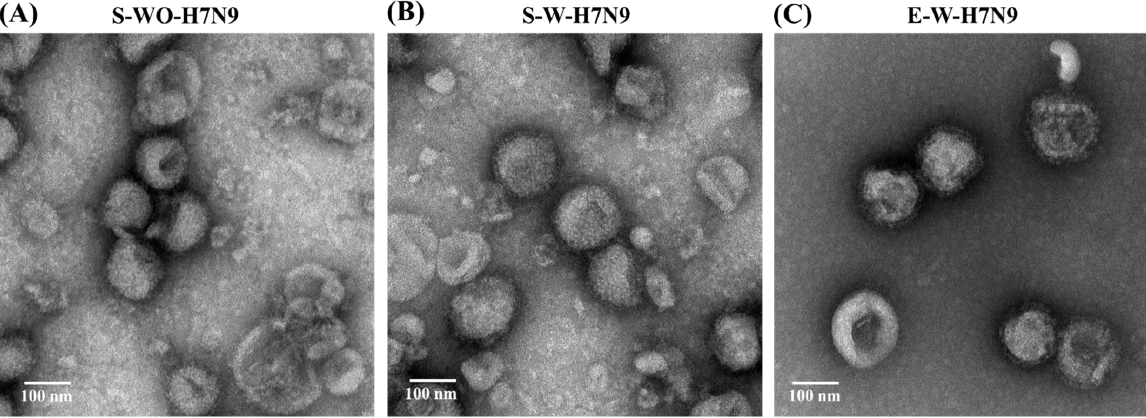
Figure 2. Morphology of three influenza H7N9 vaccine antigens analyzed using transmission elec- tron microscopy. ( A ) S-WO-H7N9; ( B ) S-W-H7N9; ( C ) E-W-H7N9. Bar = 100 nm.